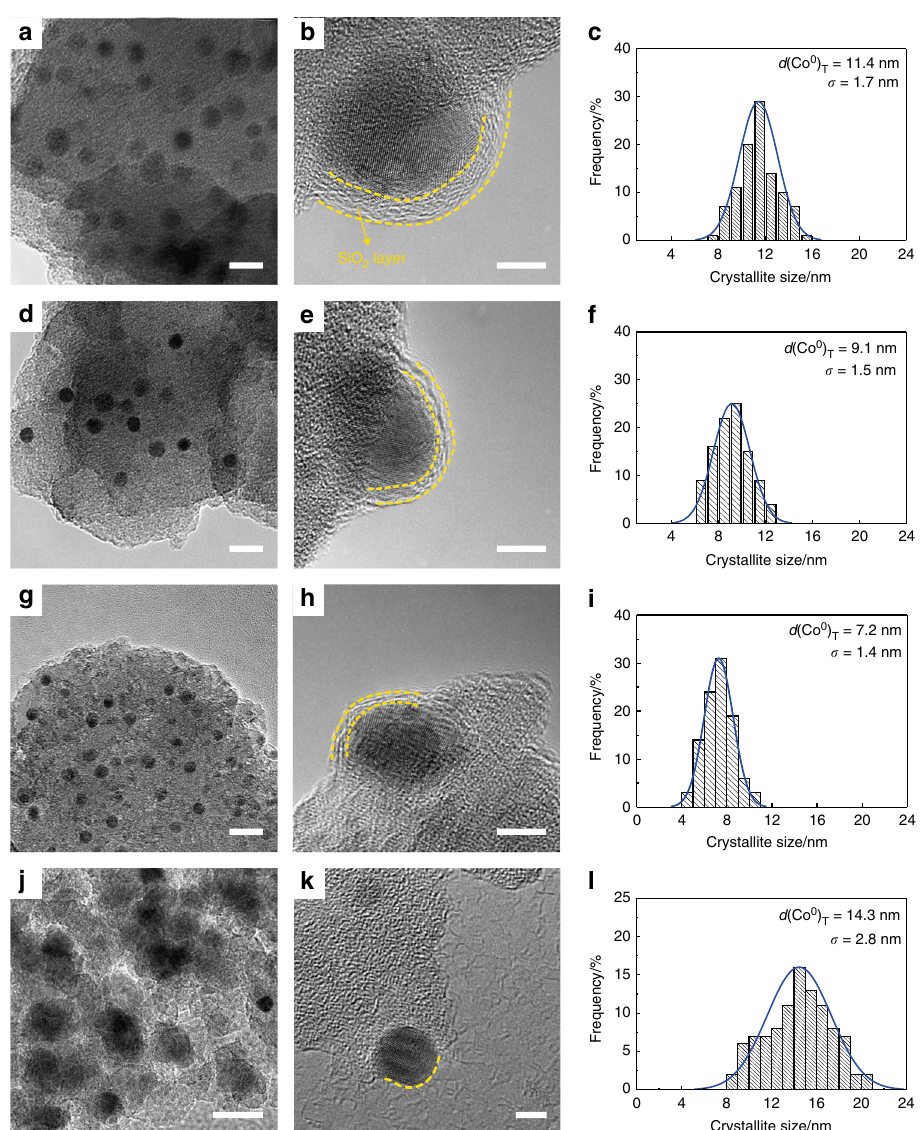
Fig. 3 TEM images and corresponding crystallite size distributions of the reduced catalysts. a , d , g , j TEM and b , e , h , k HRTEM images of the reduced Cat- x h catalysts. c , f , i , l Corresponding crystallite size distributions of the reduced catalysts. a , b , c Cat-12h, d , e , f Cat-8h, g , h , i Cat-4h, and j , k, l Cat-IM. Scale bars: a , d , g , j 20 nm; b , e , h , k 5